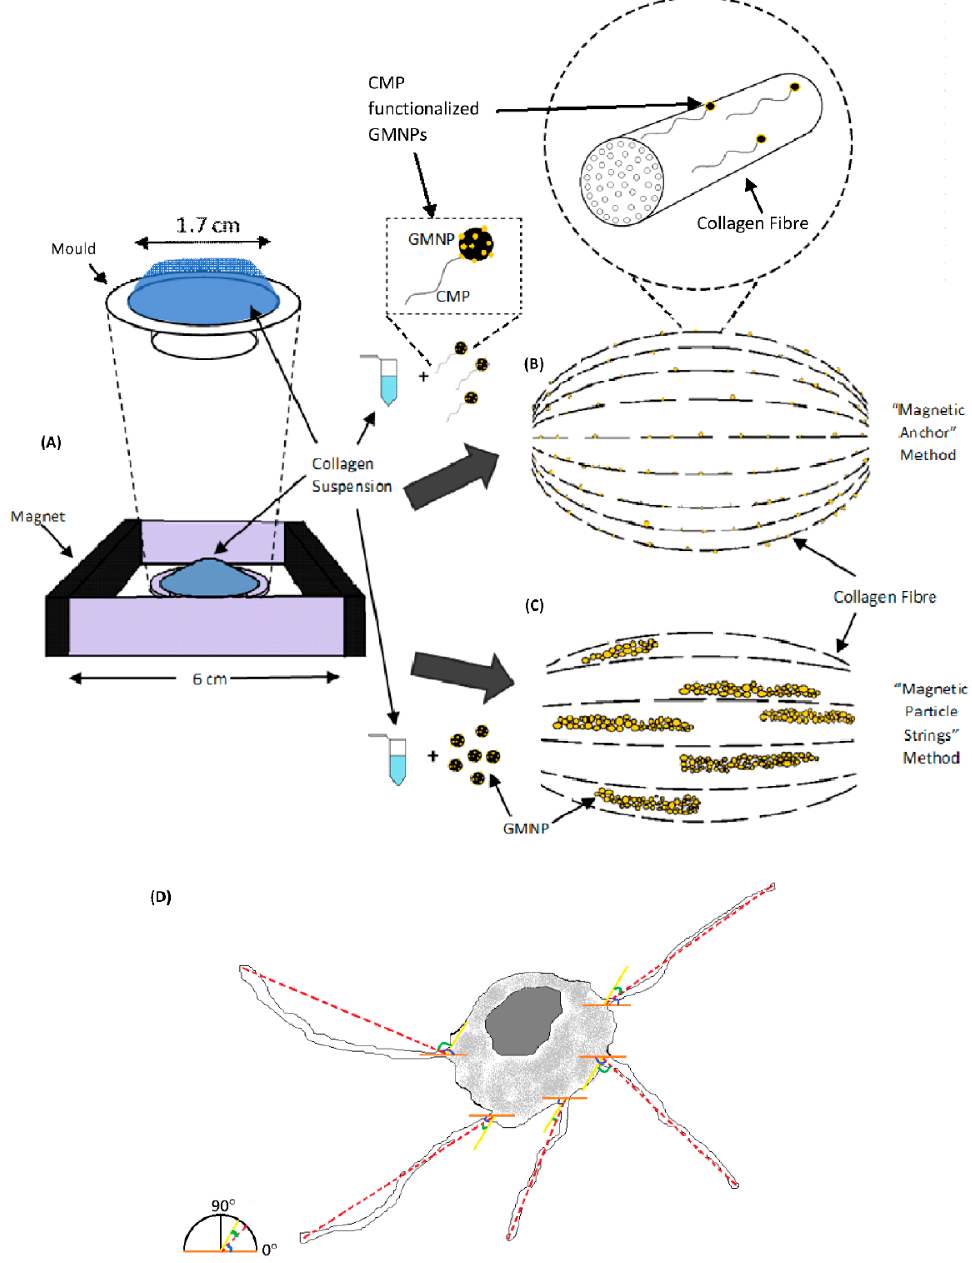
Figure 8. Schematic overview of the magnetic field set-up and methods compared in aligning collagen fibres ( A ). The experimental set-up that enabled the application of magnetic field to collagen gels ( B ). Collagen fibre alignment using the “magnetic anchor” method ( C ). The PC12 cell schematic in ( D ) shows the method by which the angle of alignment (blue angle) and the angle of deviation from the mean angle of alignment (green angle) was derived. The dotted red line represents the neurites’ alignment plane. The orange line represents the horizontal plane (0 ◦ ). The yellow line represents the mean angle of the alignment